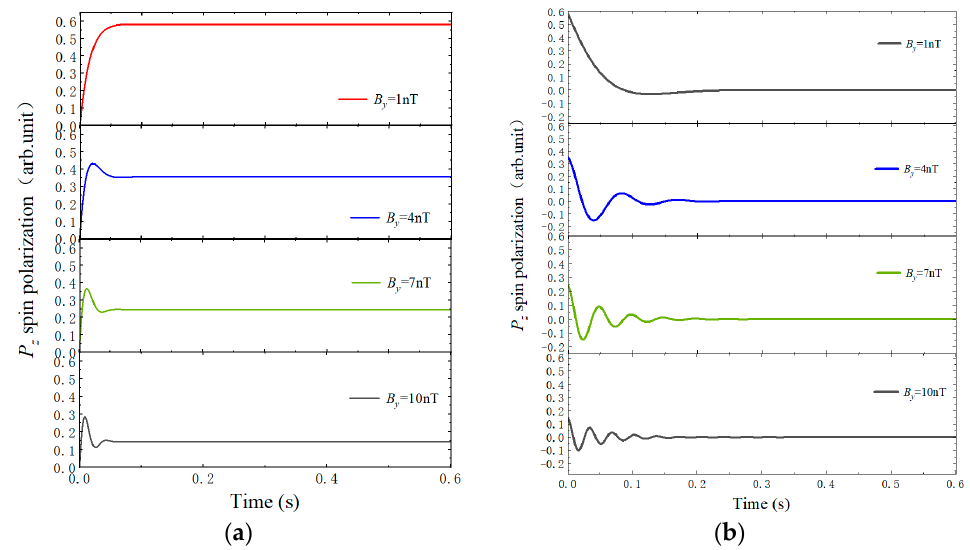
Figure 3. Simulation results of the magnetometer z axis polarization oscillation decay process at di ff erent magnetic fi elds B y . ( a ) Pumping light in the on state. ( b ) Pumping light in the o ff state.